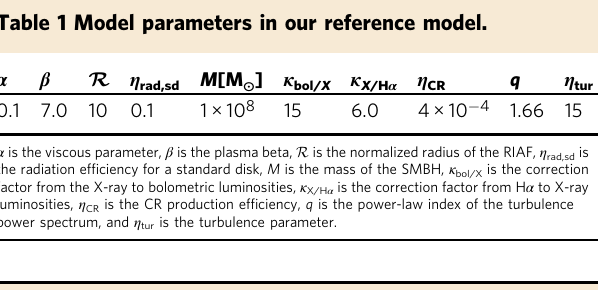
(cid:1) syn ; ch (cid:1) 3 x = h eB Θ 2 syn ; ab M p e where M .